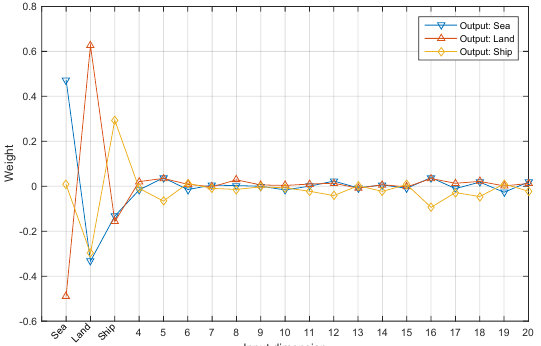
Figure 7. First 20 weights of Layer fc_a2 plotted as lines. Each line represents the weights corresponding to a specific output category (sea, land and ship) as listed in the legend. Each dot on the line represent a weight corresponding to an input dimension. The first 3 input dimensions corresponds to coarse-scale score slices of sea, land and ship, respectively, and the other dimensions corresponds to feature maps from fine-scale Layer